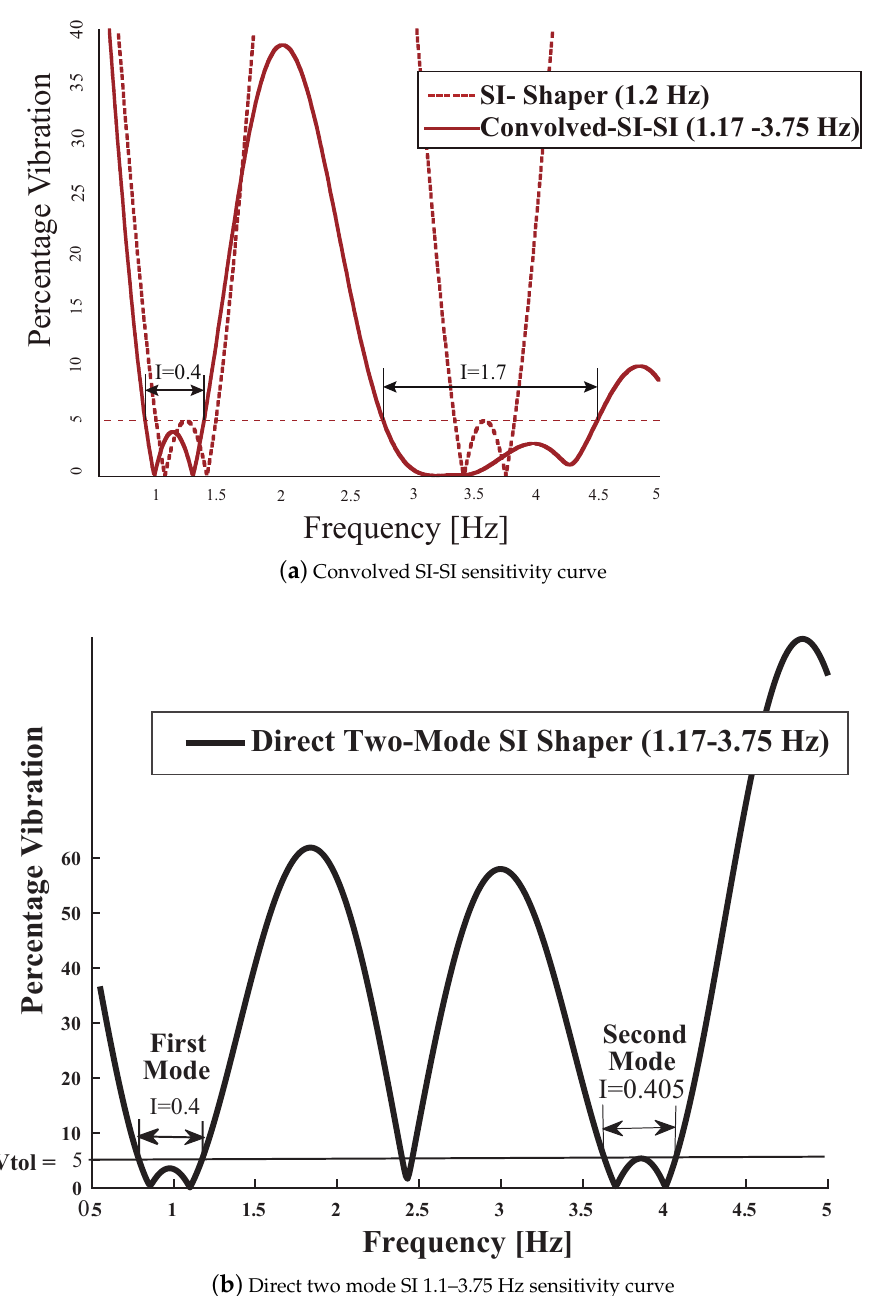
Figure 21. Convolved and Direct Two Mode SI-SI Shapers for 1.1 Hz and 3.75